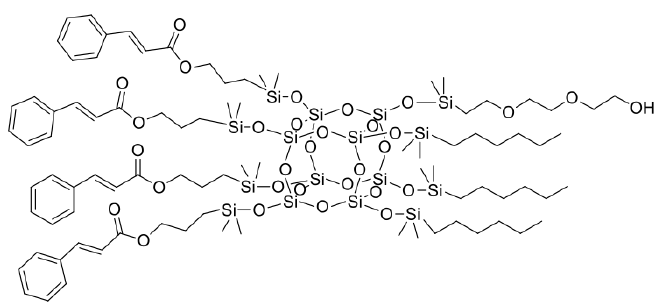
Figure 1. The chemical structure of SSQ1.